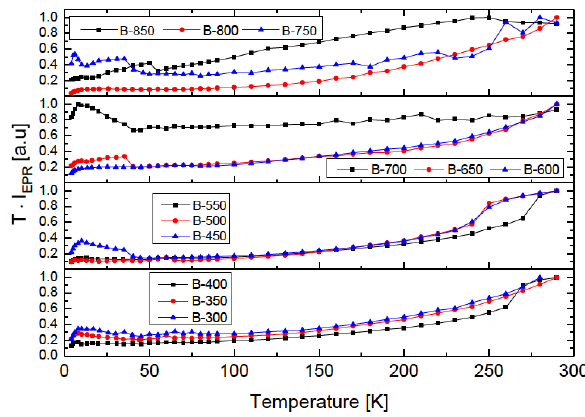
Figure 8: Temperature dependence of linewidth (top panel), inte- grated intensity (middle panel) and effective g -factor (bottom panel) for the N component in B-800 sample.